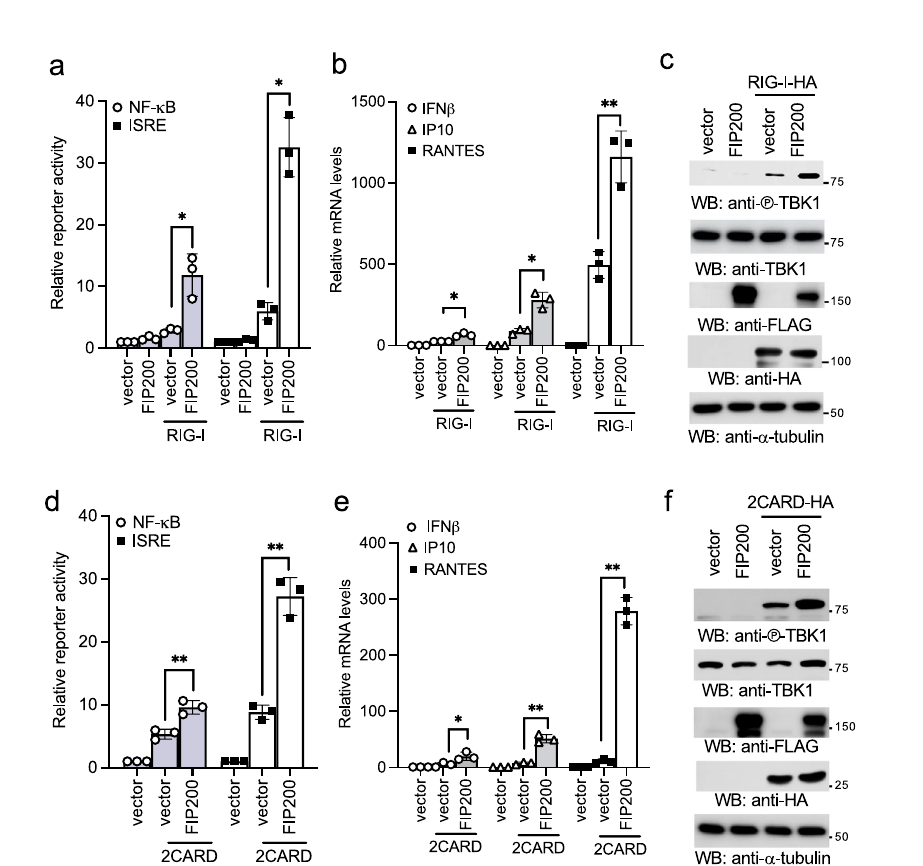
Fig. 2 FIP200 activates type I IFN signaling synergistically with RIG-I. a Two hundred ng of FLAG-tagged FIP200 was transfected with 20 ng of FLAG- tagged RIG-I and 20 ng of pRL-SV40 ( Renilla luciferase as an internal control), together with 200 ng of pISRE-Luc or NF- κ B-Luc into HEK293 cells. After 48 h, cells were collected, and the ratio of fi re fl y luciferase to Renilla luciferase was calculated to determine the relative reporter activity. All experiments were biologically repeated three times. Data represent means ± s.d. of three independent experiments. (* P < 0.05, by paired two-tailed Student ’ s t test). b RIG-I was transfected with vector or FIP200 into HEK293 cells. After 48 h, RNA was extracted, and real-time PCR for IFN β , IP10, and RANTES was performed. All experiments were biologically repeated three times. Data represent means ± s.d. of three independent experiments. (* P < 0.05, ** P < 0.01, by paired two- tailed Student ’ s t test). c RIG-I was transfected with vector or FIP200 into HEK293 cells. After 48 h, cell lysates were blotted as indicated. d Two hundred ng of FLAG-tagged FIP200 was transfected with 20 ng of 2CARD-FLAG and 20 ng of pRL-SV40, together with 200 ng of pISRE-Luc or NF- κ B-Luc into HEK293 cells. After 48 h, cells were collected, and the ratio of fi re fl y luciferase to Renilla luciferase was calculated to determine the relative reporter activity. All experiments were biologically repeated three times. Data represent means ± s.d. of three independent experiments. (** P < 0.01, by paired two- tailed Student ’ s t test). e The 2CARD was transfected with vector or FIP200 into HEK293 cells. After 48 h, RNA was extracted, and real-time PCR for IFN β , IP10, and RANTES was performed. All experiments were biologically repeated three times. Data represent means ± s.d. of three independent experiments. (* P < 0.05, ** P < 0.01, by paired two-tailed Student ’ s t test). f The 2CARD was transfected with vector or FIP200 into HEK293 cells. After 48 h, cell lysates were blotted as